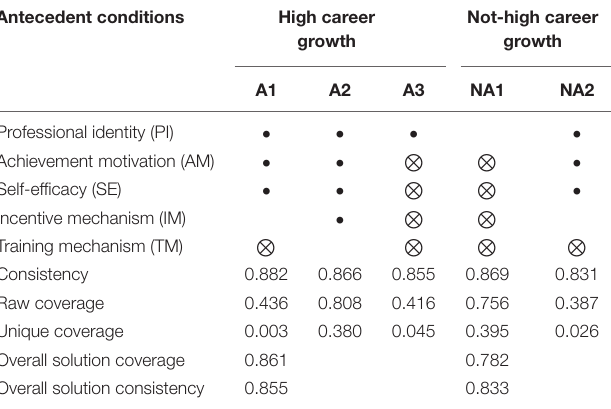
TABLE 5 | Configurations for achieving GPs career growth